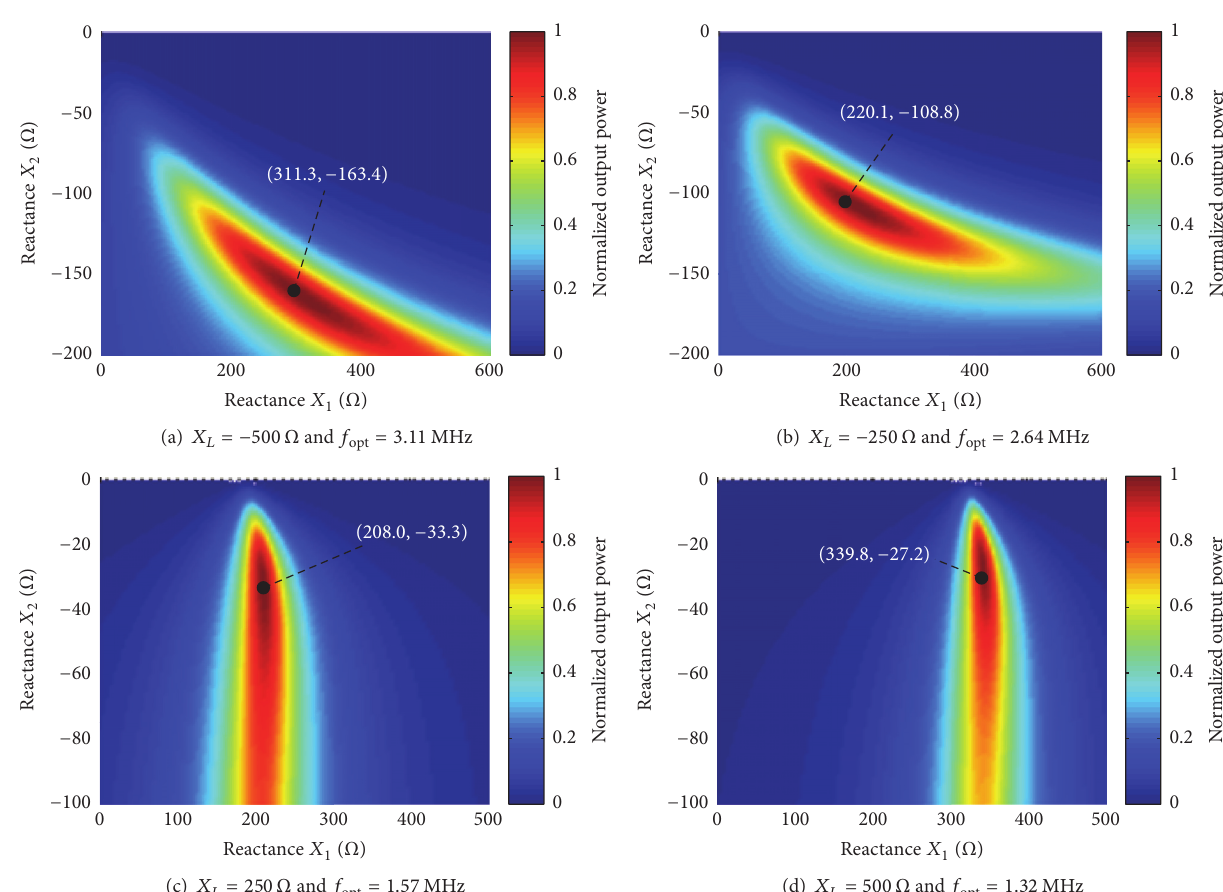
Figure 5: Calculated 𝑃 out versus 𝑋 1 and 𝑋 2 . The load resistance 𝑅 𝐿 = 100 Ω